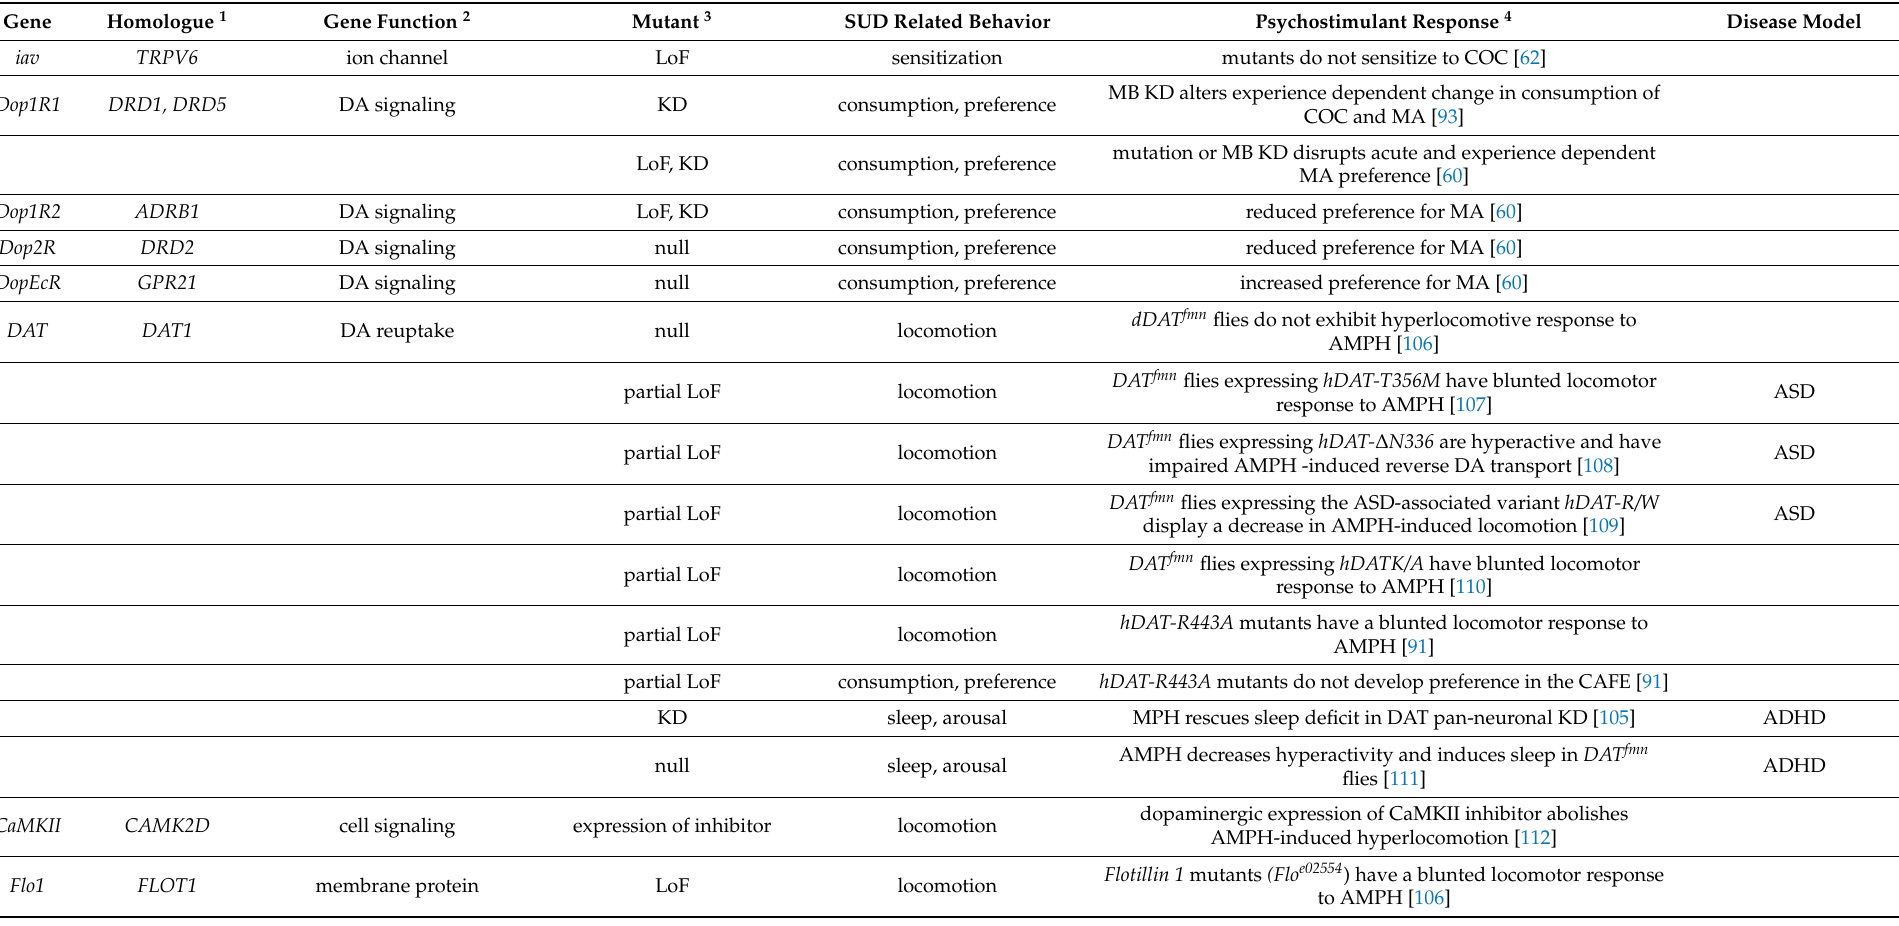
Table 1. Genes involved in Drosophila psychostimulant